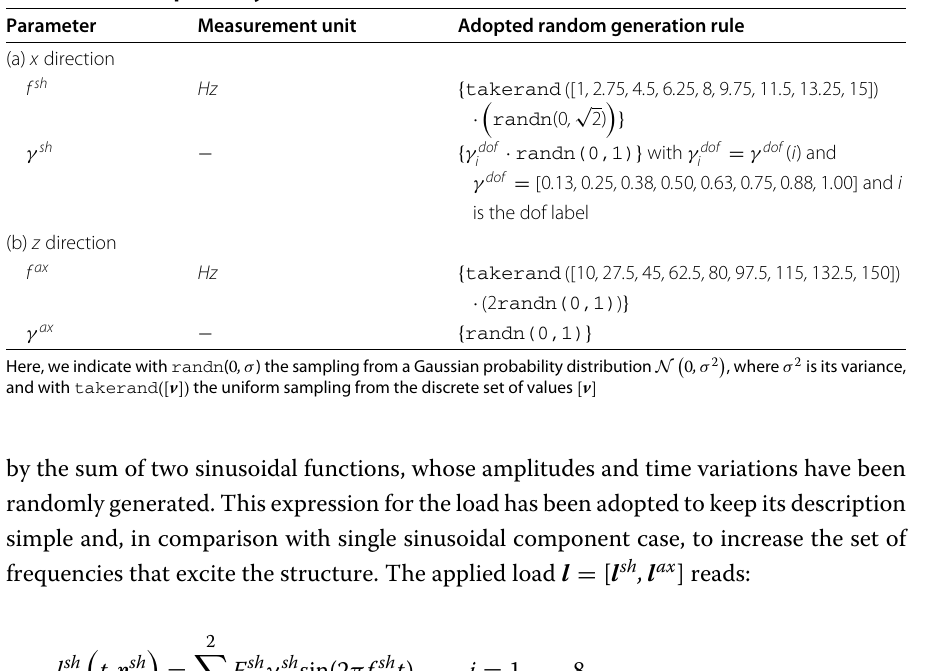
and η 1 ax tuning the l l